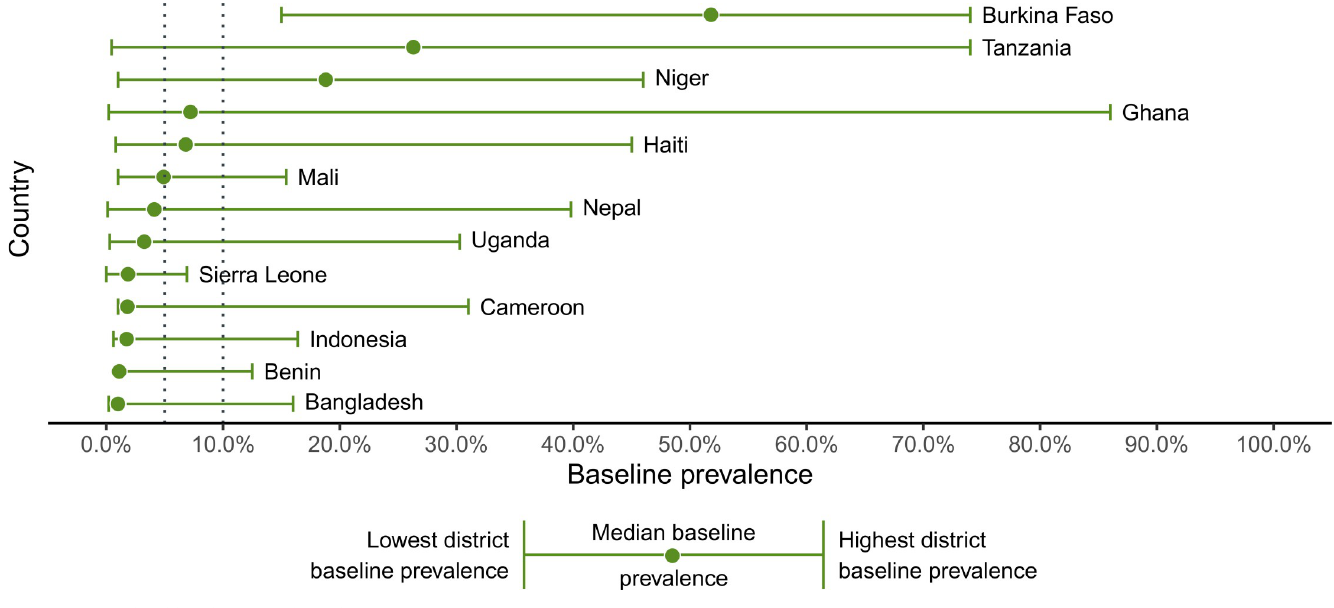
PLOS NeglectedTropical Diseases | https://doi.org/10.1371/journal.pntd.0008301 June 1,